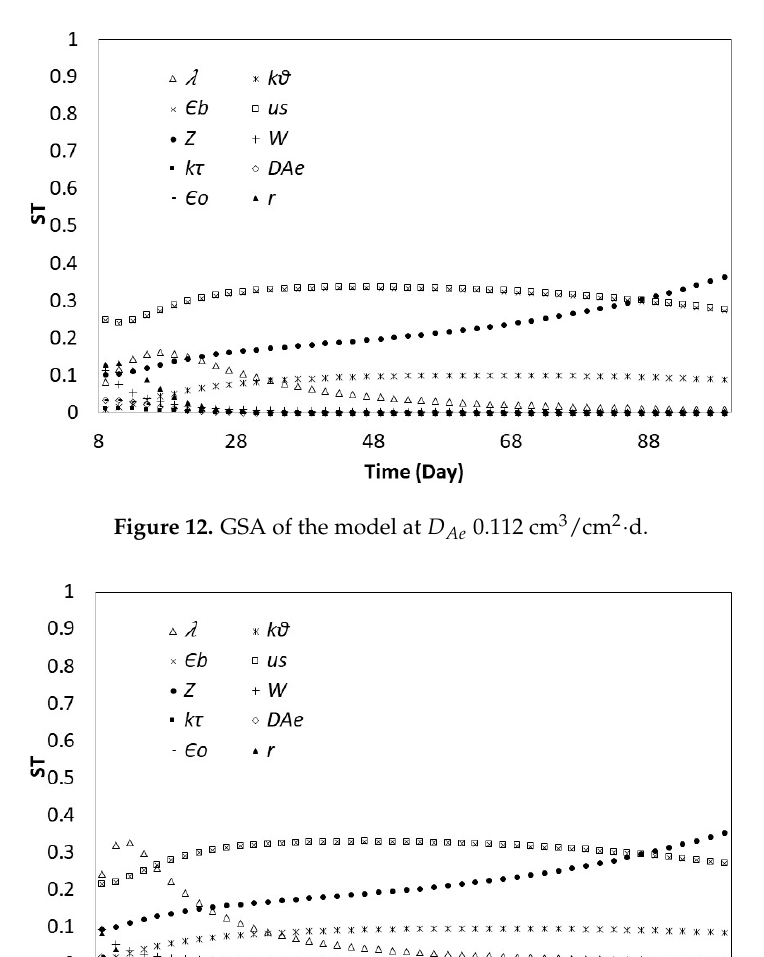
Figure 11. GSA of the model at (cid:1830) (cid:3002)(cid:3032) 0.06 cm 3 /cm 2 d.